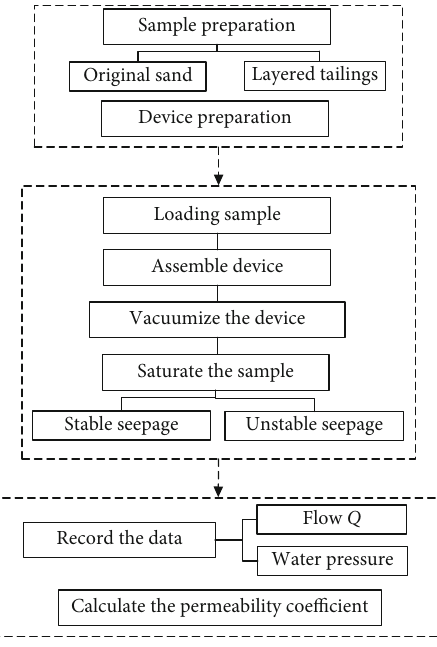
Figure 4: The procedure of the seepage